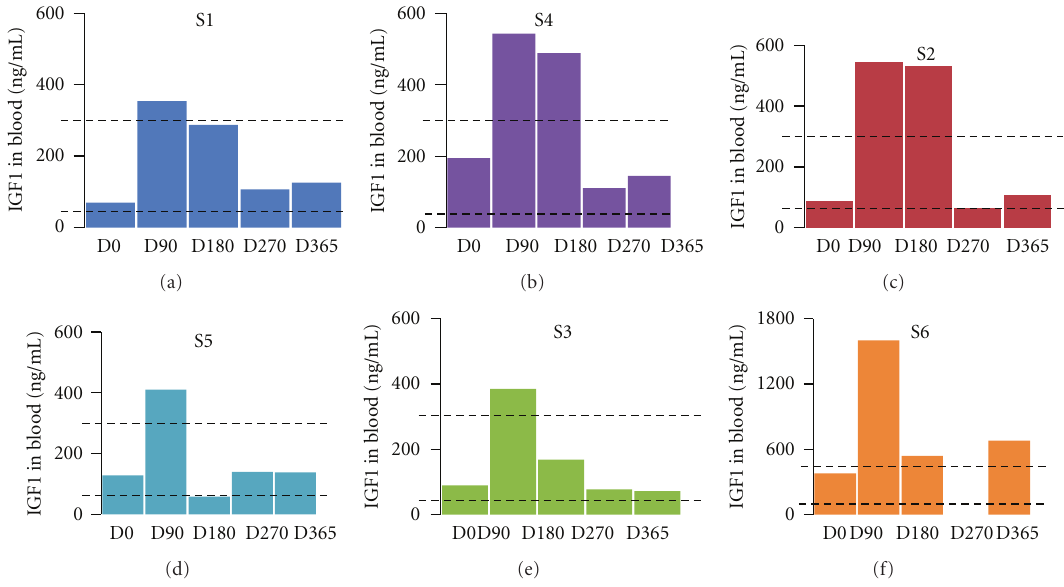
Figure 1: IGF1 serum levels during the treatment. IGF1 levels in the blood were tested at each hospitalization: D0 (first day of treatment, before IGF administration), D90 (90 days after the first IGF1 administration), D180 (180 days after the first IGF administration, last day of IGF1 treatment), D270 (270 days after the first IGF administration), and D365 (365 days after the first IGF administration). The dotted lines represent the normal range of IGF1 in each patient. The amount of IGF1 is expressed in ng/mL and reported for each patient, and it is color-coded: S1: blue, S2: red, S3: green, S4: purple, S5: cyan, and S6: orange. The data for S6 at D270 is not available. The serum levels of IGF1 rose for each patient during the treatment and returned back to control levels after the end of the